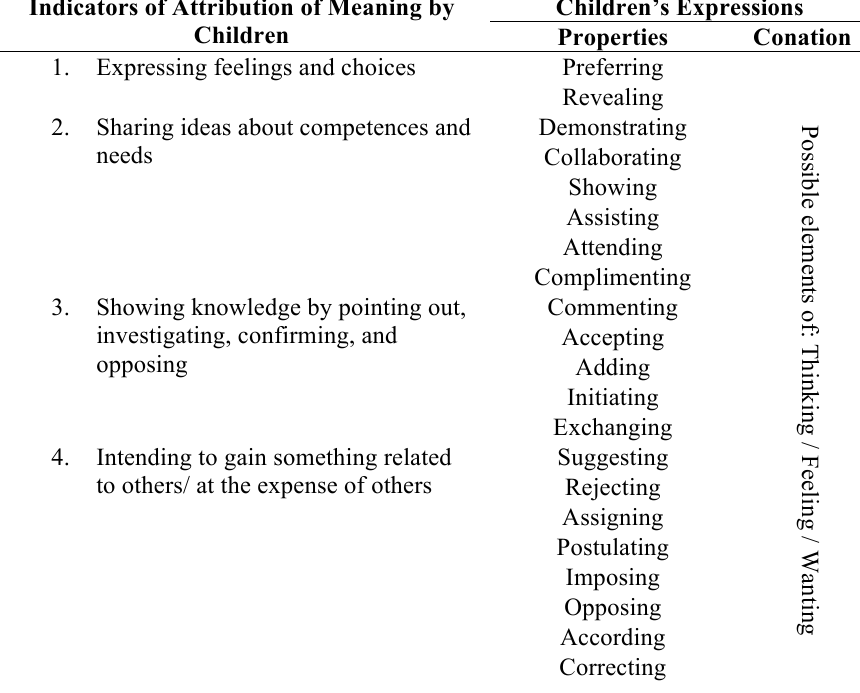
Indicators of Attribution of Meaning, Related to Characterizations of Children’s Expressions (Properties With Possible Elements of Conation: Thinking, Feeling, Wanting)